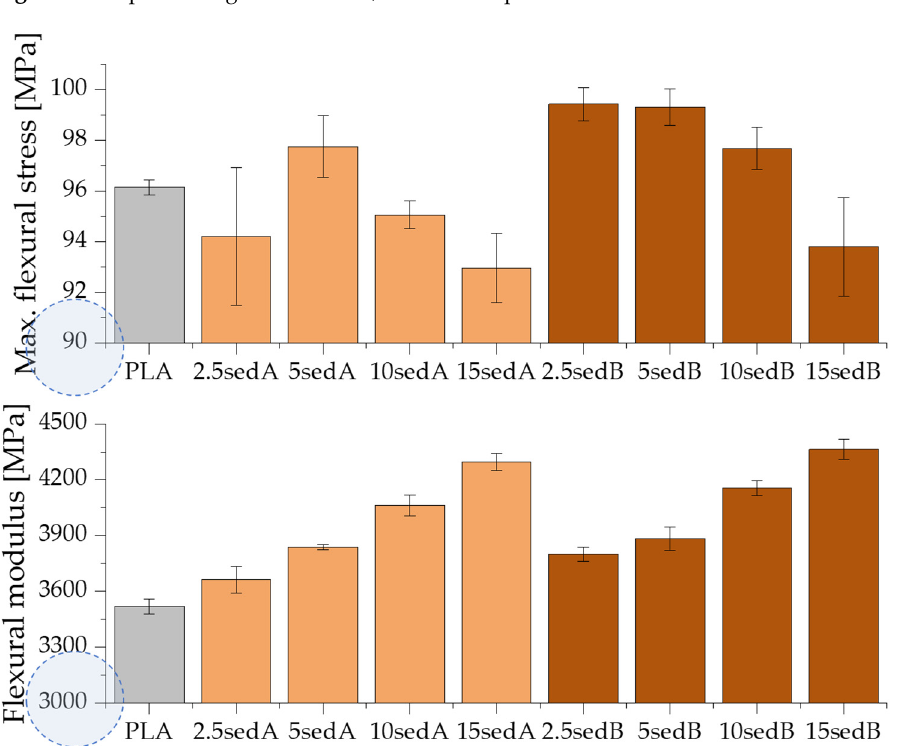
Figure 12. Flexural strength of PLA/sedA-B composites.